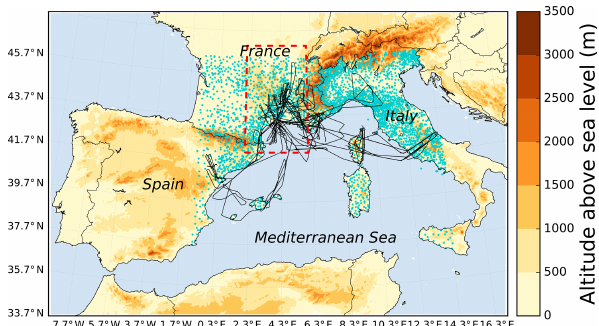
Figure 1. The Falcon 20 flight paths (black lines) during the HyMeX first Special Observation Period over the AROME-WMED domain. The altitude of ground above sea level (in metres) is rep- resented by the coloured gradient. Rain gauges are represented by the blue markers. The area surrounding the IOP7a case study is in- dicated by the red